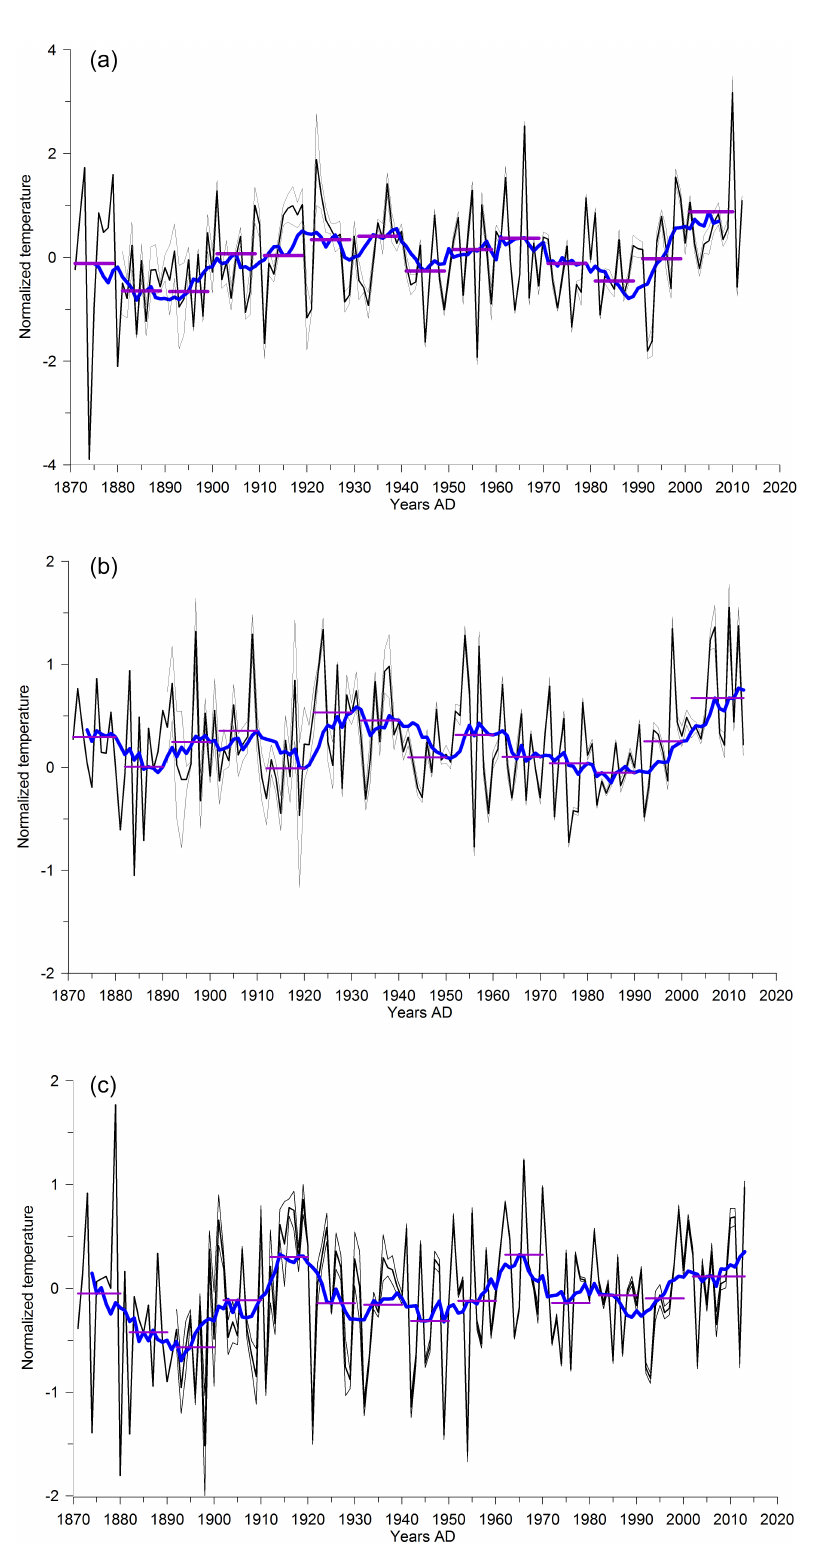
Figure 8. Normalized regional temperature record based on meteorological data, with respect to the reference period 1966–1990, expressed as annual anomalies ( ◦ C). The thin lines illustrate the standard deviation across the individual records after accounting for the lapse rate from Fig. S3; the blue line shows a 10-year running mean, and the horizontal purple line demonstrates the decadal mean value. Panel (a) shows the annual means, (b) shows the warm season, and (c) shows the cold